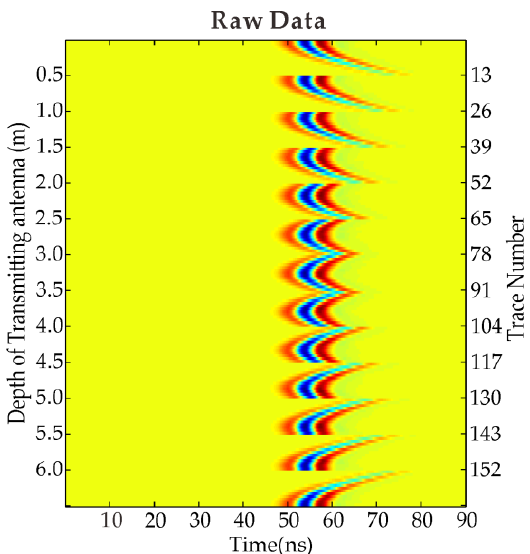
Figure 2. Raw data of simple synthetic model with two pipeline bodies buried in homogeneous medium.